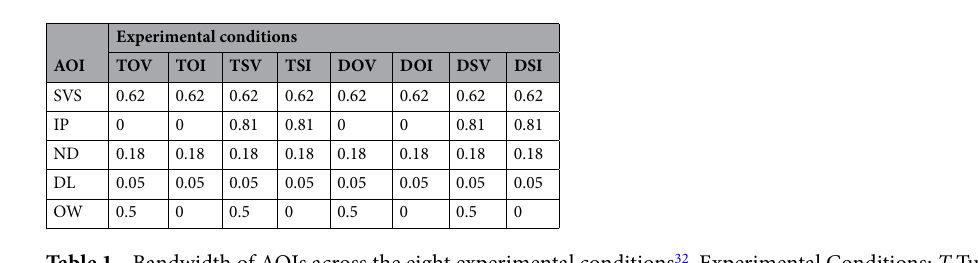
Table 1. Bandwidth of AOIs across the eight experimental conditions 32 . Experimental Conditions: T Tunnel, D Datalink, O Overlay, S Separate, V VMC, I